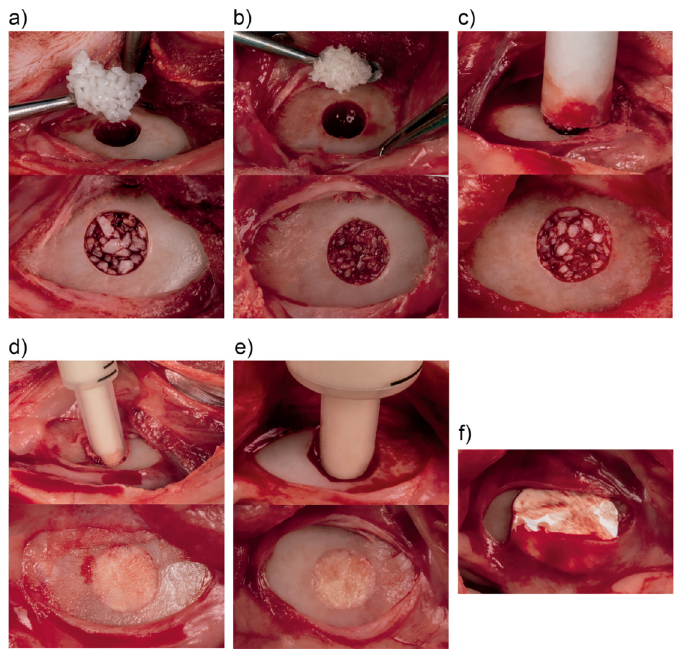
Figure 1. Intraoperative photography of material placement: ( a ) Apatos; ( b ) Gen-Os; ( c ) mp3; ( d ) Putty; ( e ) Gel 40; ( f ) Evolution